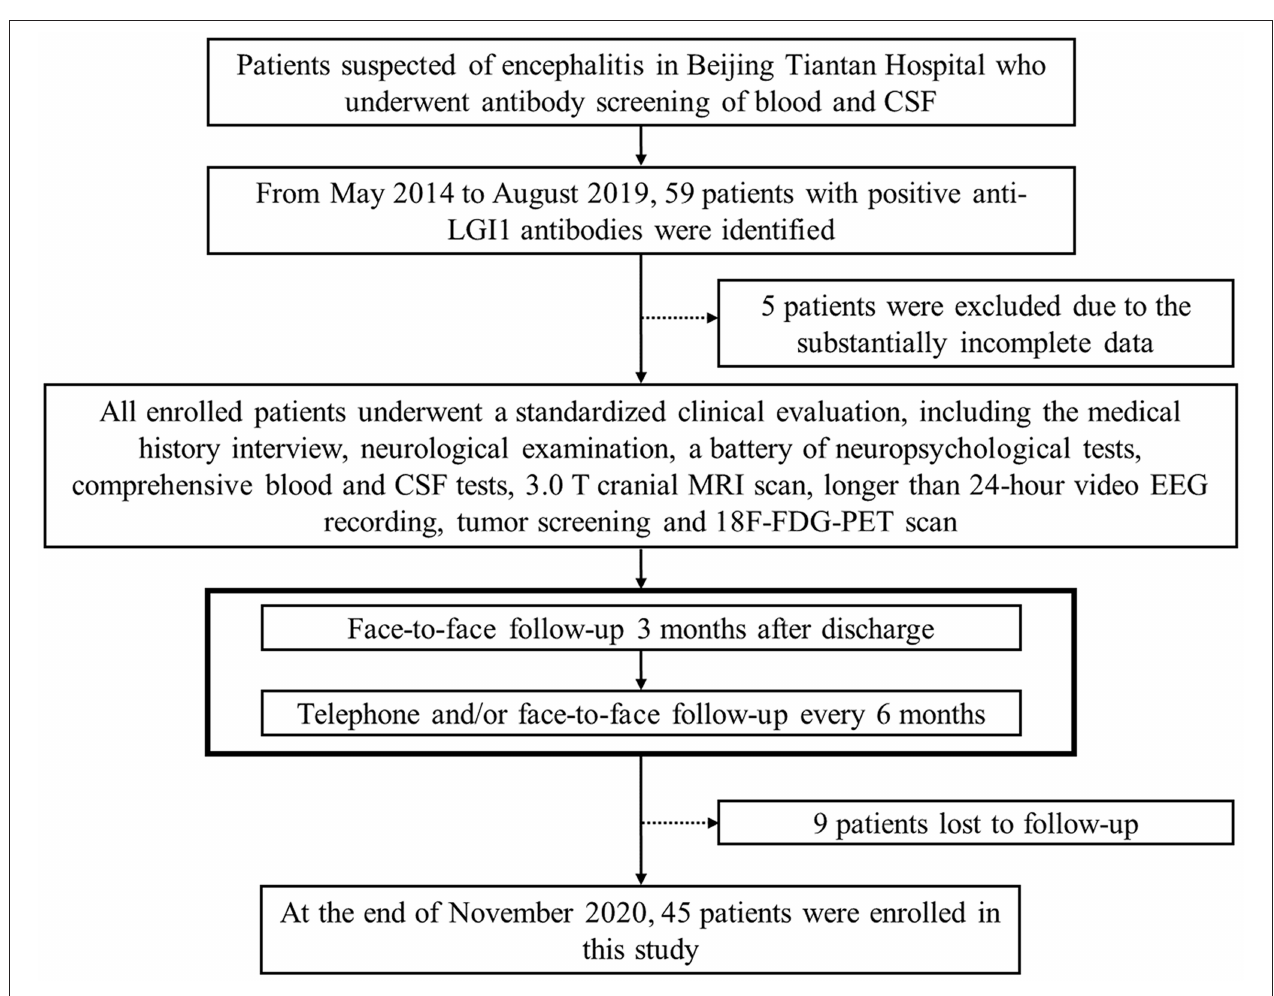
FIGURE 1 | Flowchart of the patient selection process. CSF, cerebrospinal fluid; LGI1, leucine-rich glioma-inactivated protein 1; MRI, magnetic resonance imaging; EEG, electroencephalography; 18F-FDG-PET, 18-fluoro-deoxyglucose positron emission